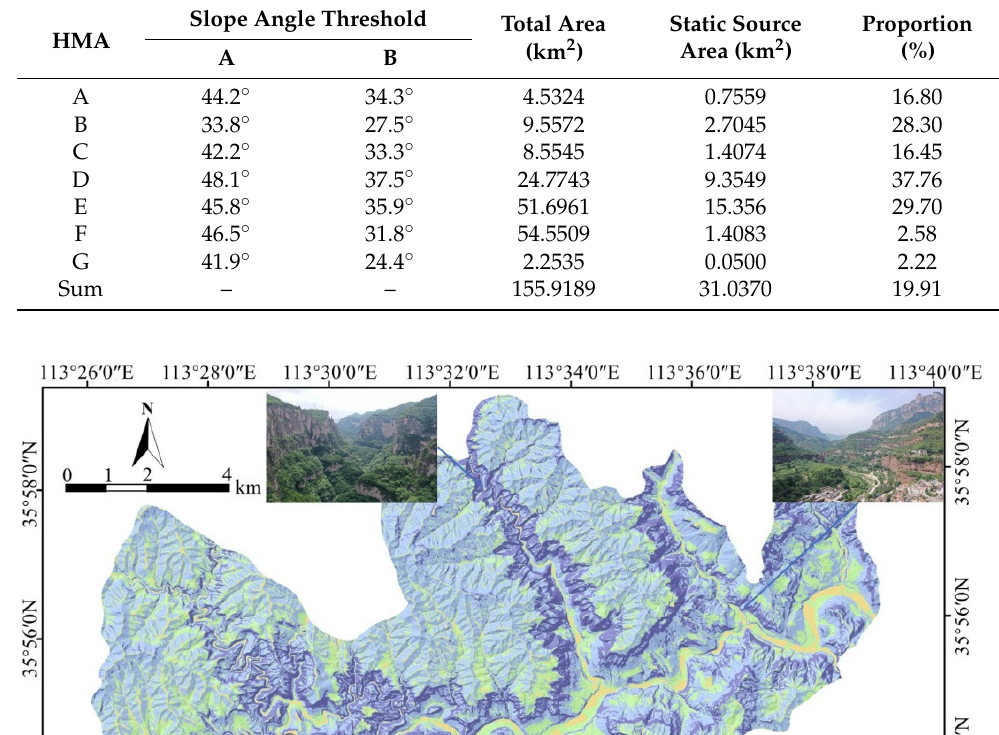
Table 5. Slope angle threshold and static source area distribution for each HMA.